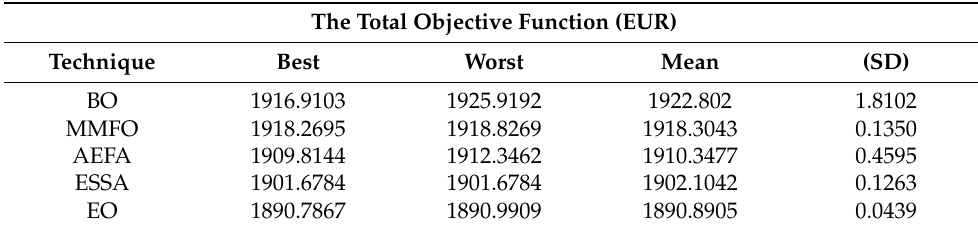
Table 13. Comparison of the statistical results of the objective function in Case